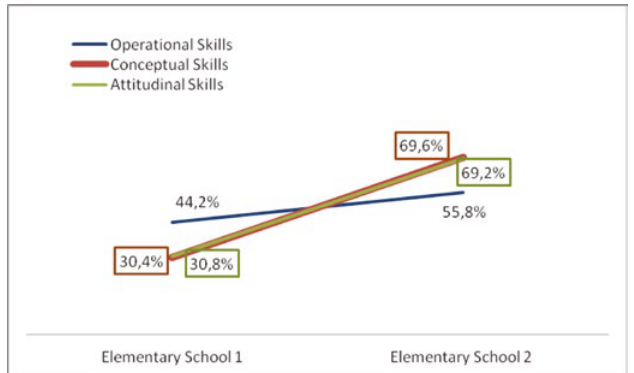
Figure 5: Skills by the level of education -